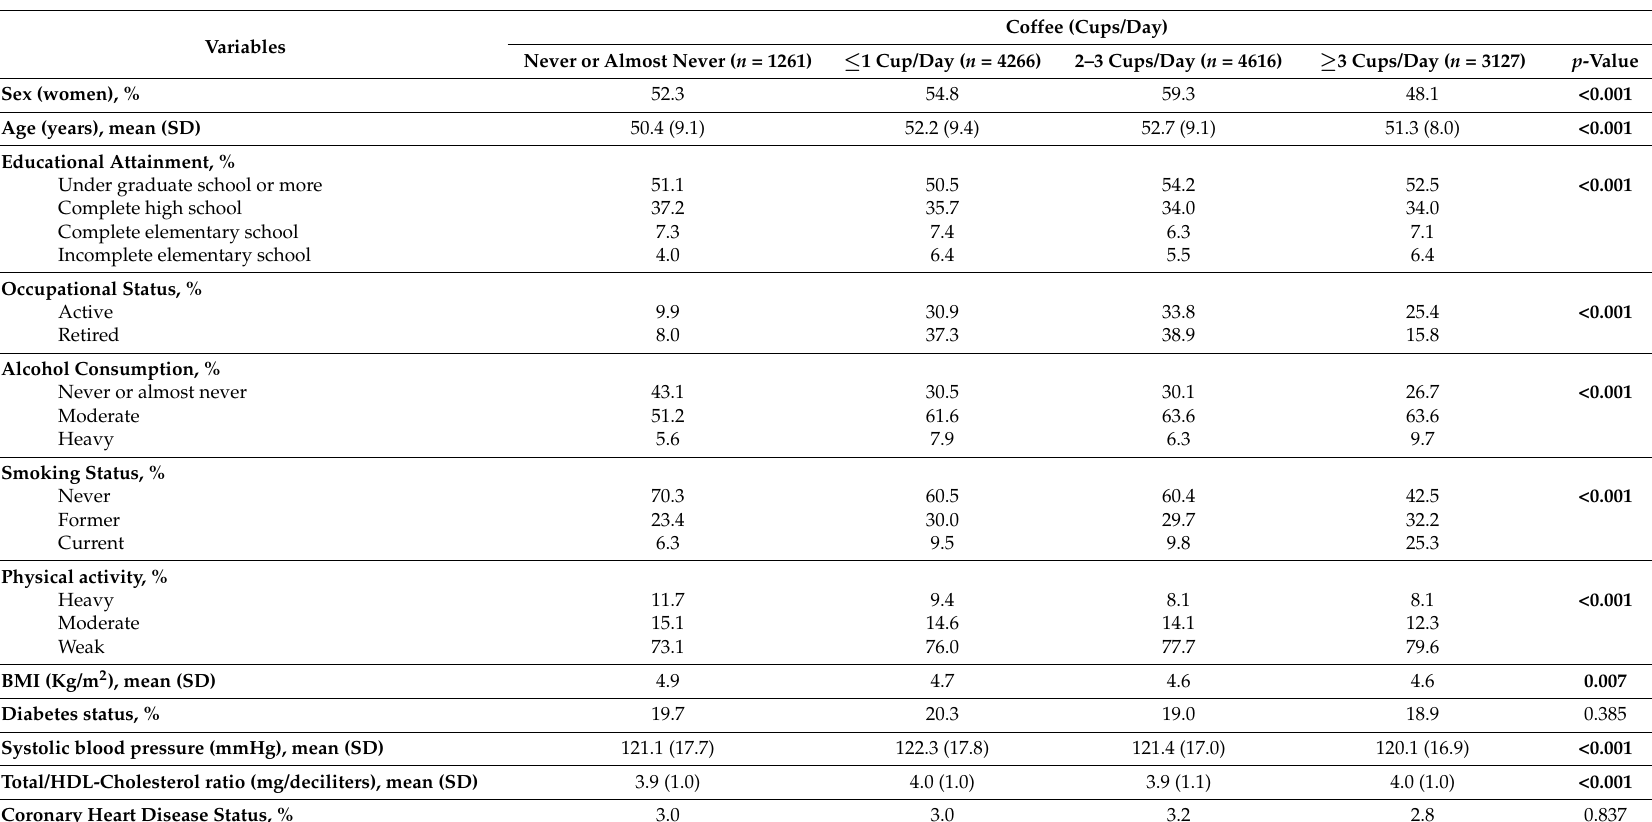
Table 1. Characteristics of the study population (35–74 years) by coffee consumption frequency in the last 12 months in Brazilian Longitudinal Study of Adult Health (ELSA-Brasil) participants